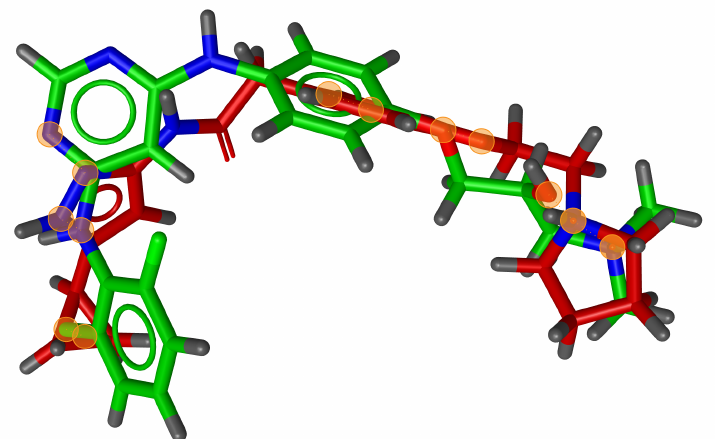
Figure 7. RM method example alignment of two molecules; four matching feature pairs were found. Orange circles = centre of matched features.